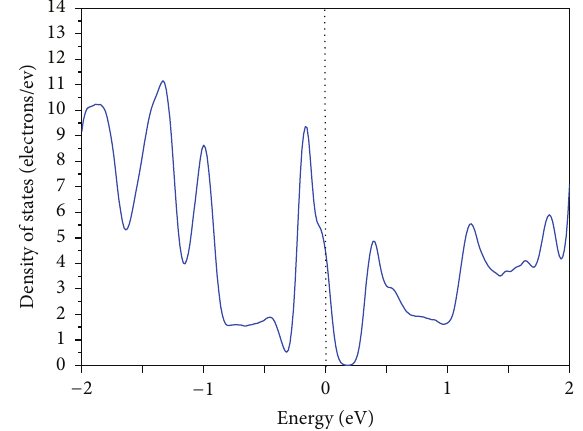
Figure 10: Density of states (DOS) of N2-doped single walled zigzag (5,0) BNT. The Fermi energy is set corresponding to zero energy and represented by dotted